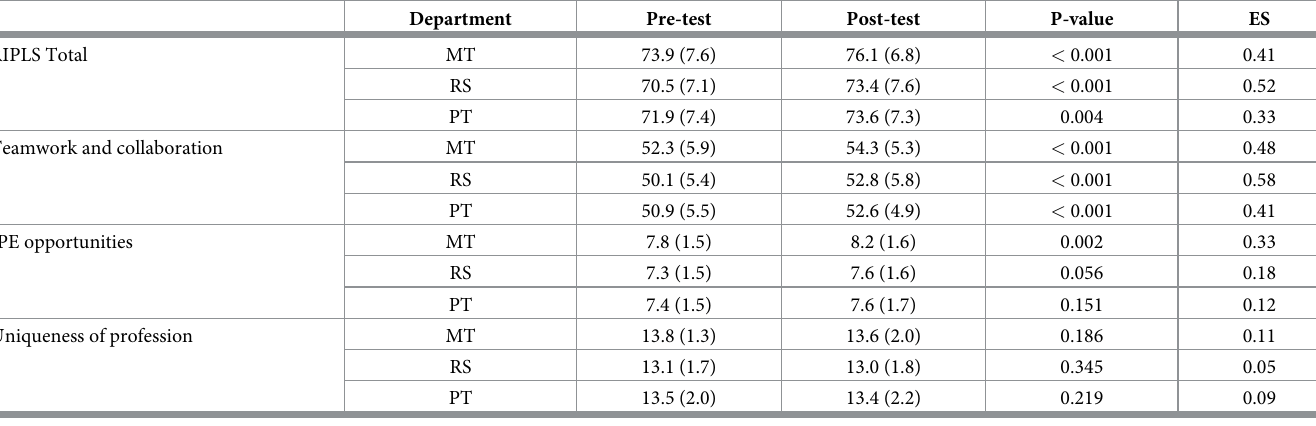
Table 1. RIPLS results for each department before and after the Biophysical Diagnosis